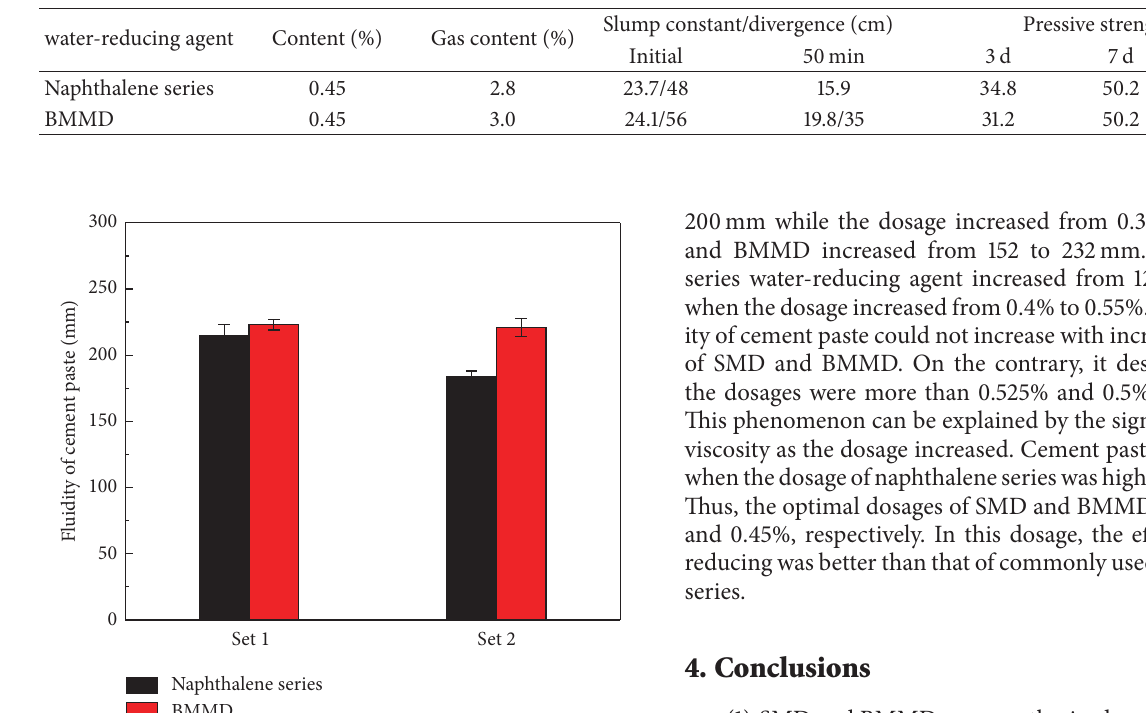
Table 6: Concrete performance.